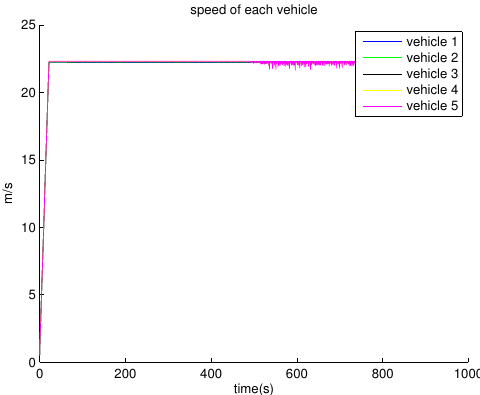
Figure 6. The speed of every heterogeneous truck converges to the speed of the leader as time goes on. γ = 1.001 is used. See that the deviation of every truck’s speed decreased, compared to the case where γ = 1.01 in Figure 4. Compared to the case where γ = 1.01, the speed noise